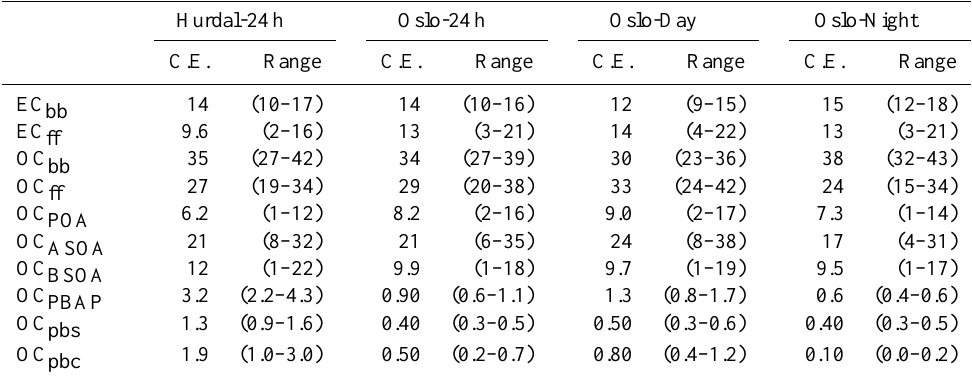
Table 9. Calculated percentage contributions to total carbon from LHS analysis, PM 1 , winter sampling (1st-8th March 2007). C.E. is central estimate (50th percentile), range is 10th–90th percentiles of LHS